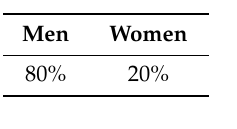
Table 3. Division of tested persons based on gender.